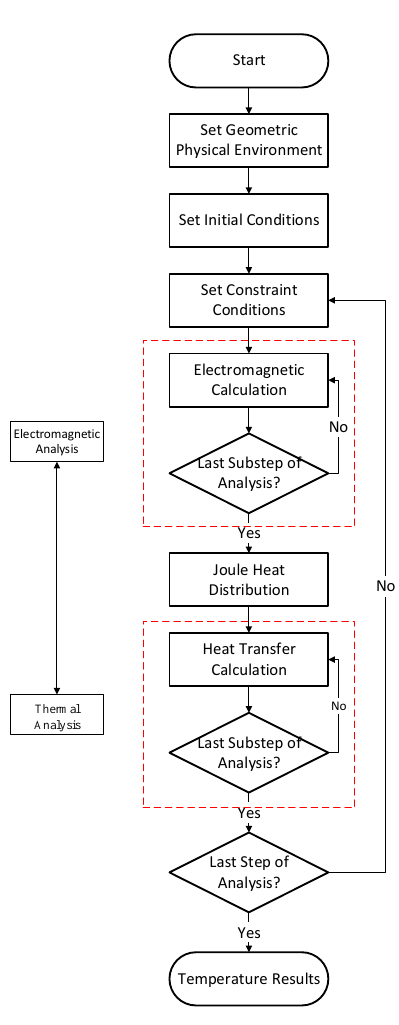
Figure 1. Electromagnetic-thermal computation process.